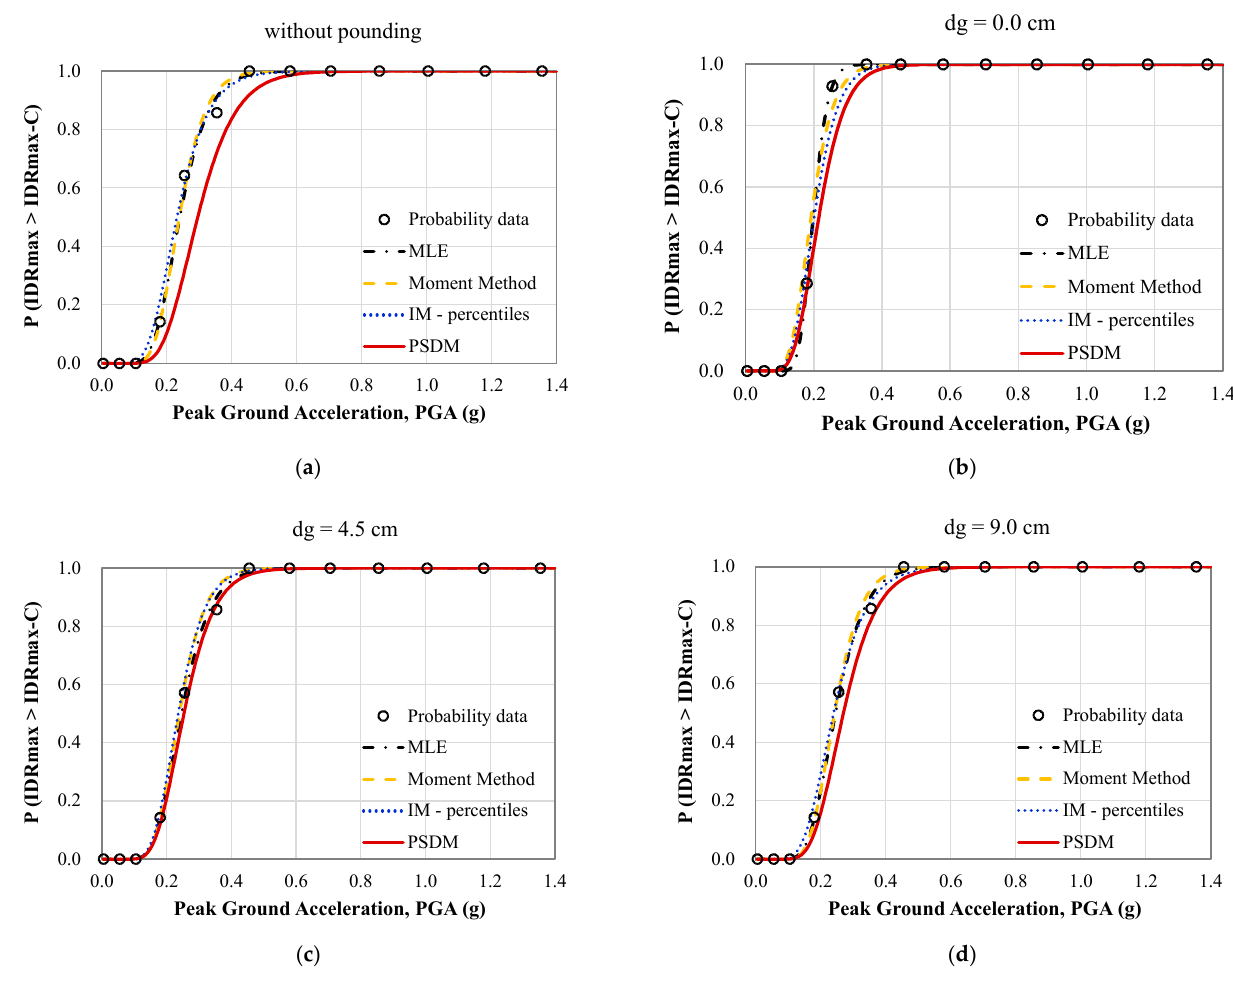
Figure 5. MLE, MM, IM percentiles, PSDM methodologies for the fragility assessment of the eight-story RC frame in terms of maximum interstory drift (IDR max -%h st ) as a function of the PGA. Examined cases: ( a ) without the pounding effect, ( b ) d g = 0.0 cm, ( c ) d g = 4.5 cm, and ( d ) d g = 9.0 cm.